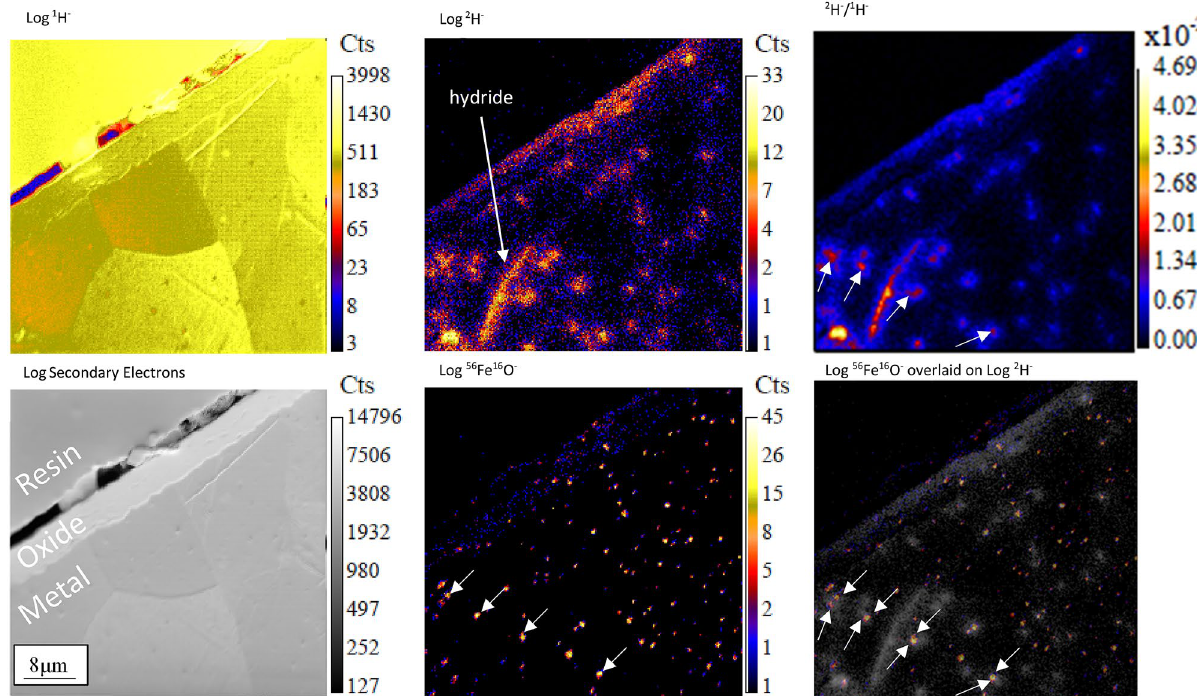
Figure 2:. 1 H − , 2 H − , Secondary electron and 56 Fe 16 O − images, the 2 H − / 1 H − ratio and an image of the 56 Fe 16 O overlaid on 2 H − image of ROI 4 from the Zy-4 sample showing the total counts summed over 6 image planes. The ROI was implanted with 4.0 × 10 17 ions/cm 2 prior to imaging and imaged with a current of 1.34 pA, a dwell time of 4000 μs/pixel and 256 × 256 pixels over a 50 μm raster